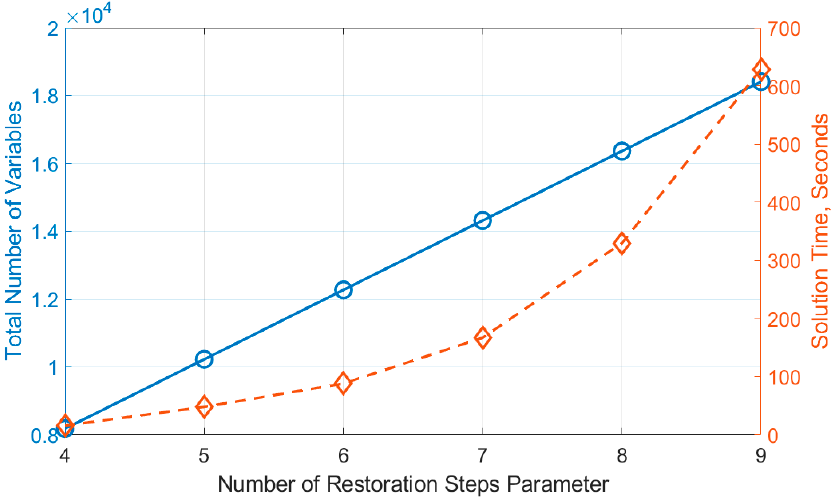
Figure 9. Effects of Increasing Restoration Steps Parameter on Number of Model Variables and Solution Time.